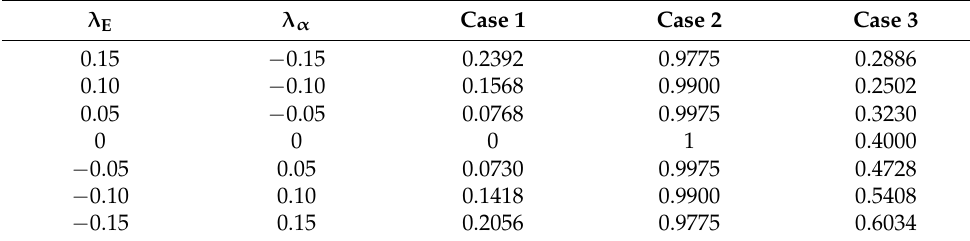
Table 2. The amplitude of stress variation under three